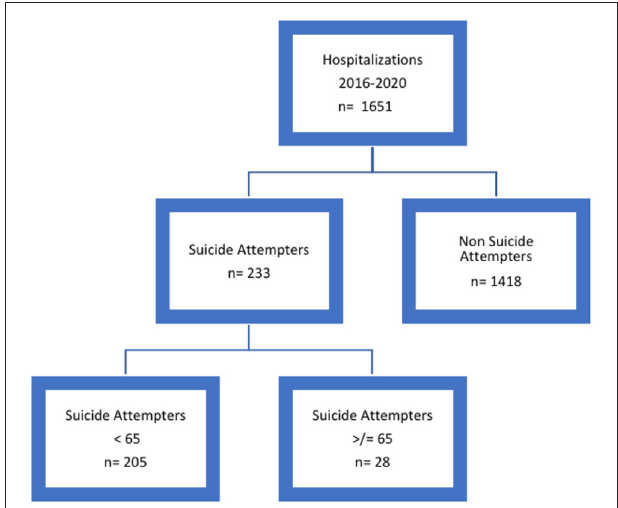
FIGURE 1 | Selection process of records and discharge summaries of